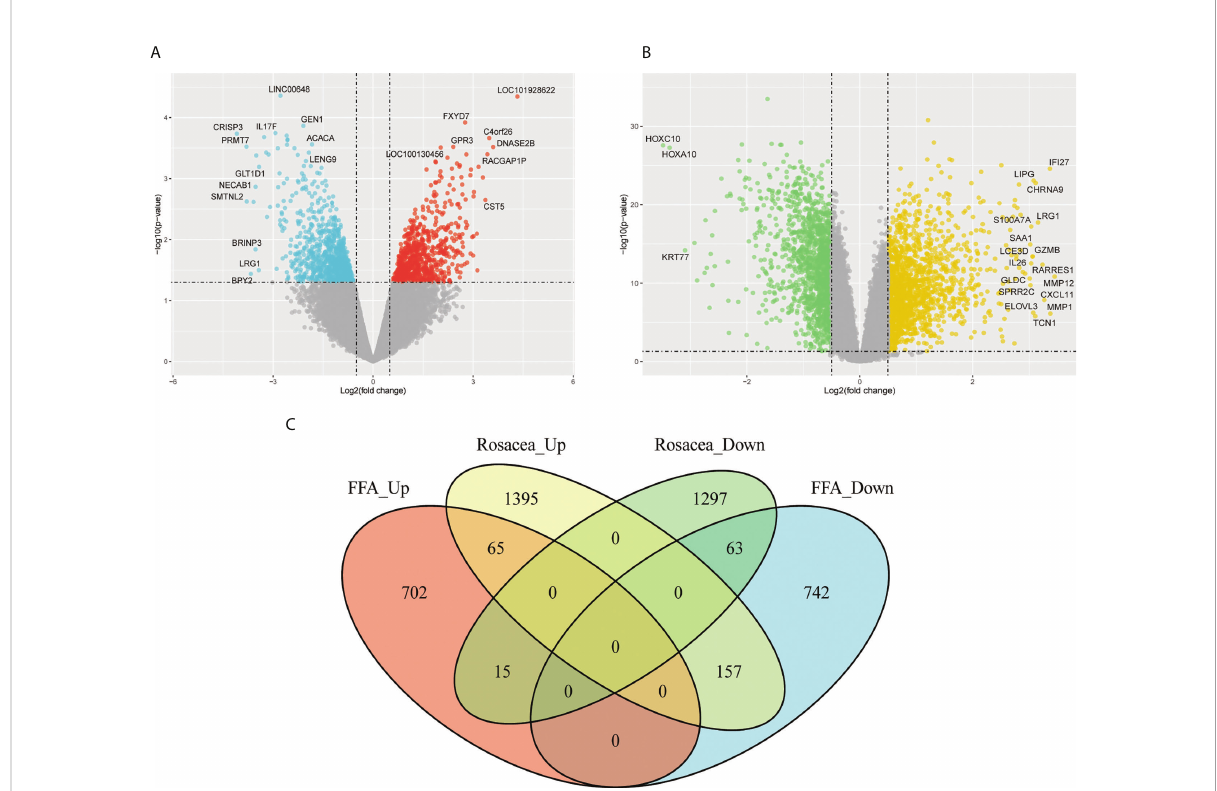
FIGURE 3 Identi fi cation of DEGs in FFA and rosacea: (A) volcano plot of the FFA dataset (GSE58934), (B) volcano plot of the rosacea dataset (GSE65914), and (C) Venn diagram of the overlap of DEGs between FFA and rosacea. DEGs, differentially expressed genes; FFA, frontal fi brosing